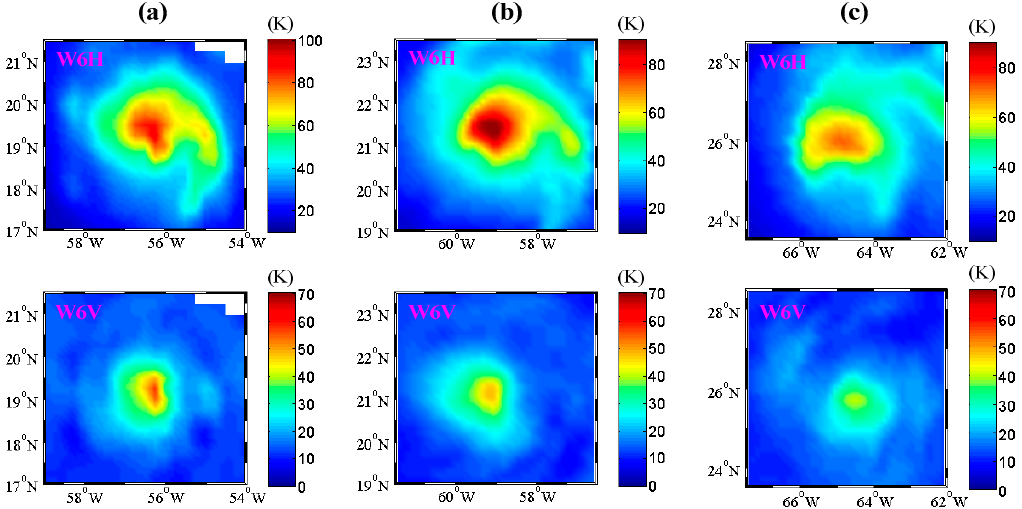
Figure 8. Brightness temperature increments of W6H and W6V over hurricane Bill on ( a ) 19 August 2009, at 1650 to 1654 UTC; ( b ) 20 August 2009, at 0512 to 0516 UTC; and ( c ) 21 August 2009, at 0555 to 0559 UTC.